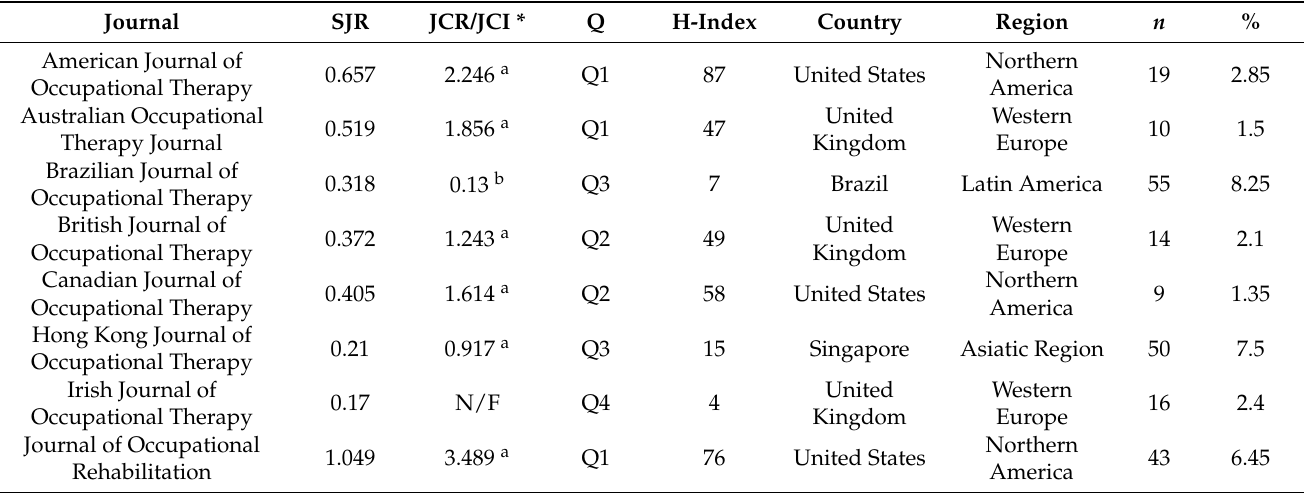
Table 3. Characteristics of the Occupational Therapy